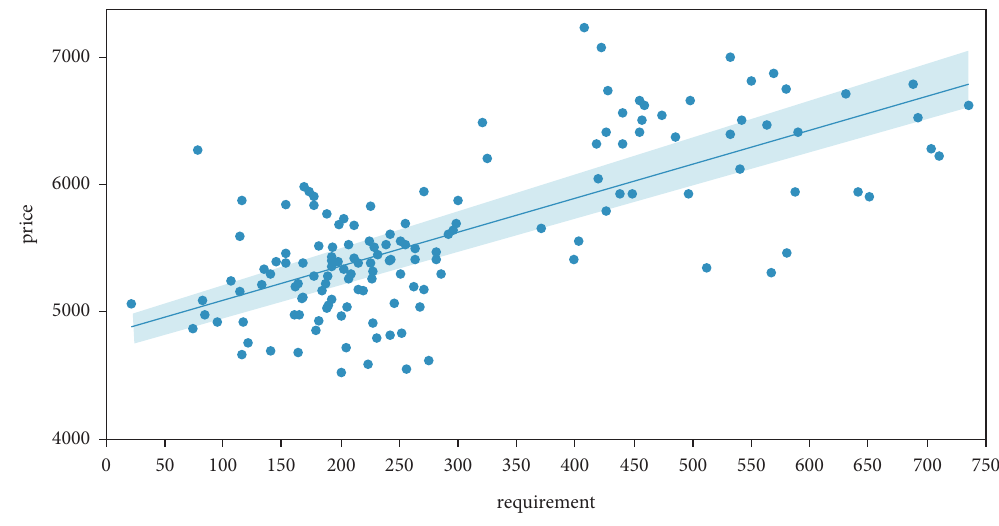
Figure 8: Demand price plot.